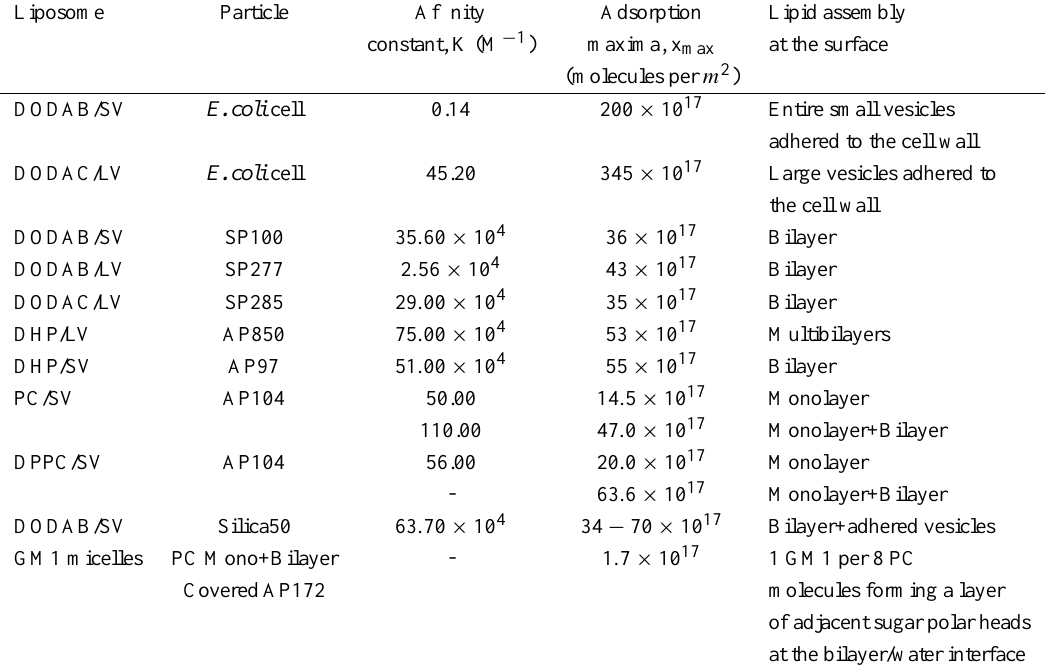
Affinities (K) and maximal adsorption (x max ) for different liposome-forming amphiphiles onto a variety of organic, inorganic or biological surfaces. Models for organic synthetic surfaces are different types of latex (polystyrene) particles; for inorganic surfaces, conventional hydrophilic silica (Aerosil OX-50) and, for biolog- ical surfaces, E. coli cell surfaces. Liposomes were obtained from the following lipids: phosphatidylcholine (PC), dipalmytoilphosphatidylcholine (DPPC), dioctadecyldimethylammonium bromide (DODAB) or chloride (DODAC), sodium dihexadecylphosphate (DHP) or monosialoganglioside (GM1). Latex particles are quoted as sulfate polystyrene (SP) or amidine polystyrene (AP) followed by the mean latex diameter in nm. Silica particles areAerosil OX-50 (50 nm mean diameter) from Degussa. Adapted fromTápias et al . 1994, Campanhã et al . 1999, Carmona-Ribeiro&Midmore1992,Carmona-Ribeiro&Herrington1993,Sicchierolli&Carmona-Ribeiro1995, Sicchierolli et al . 1995, Rapuano & Carmona-Ribeiro 1997. Liposome Particle